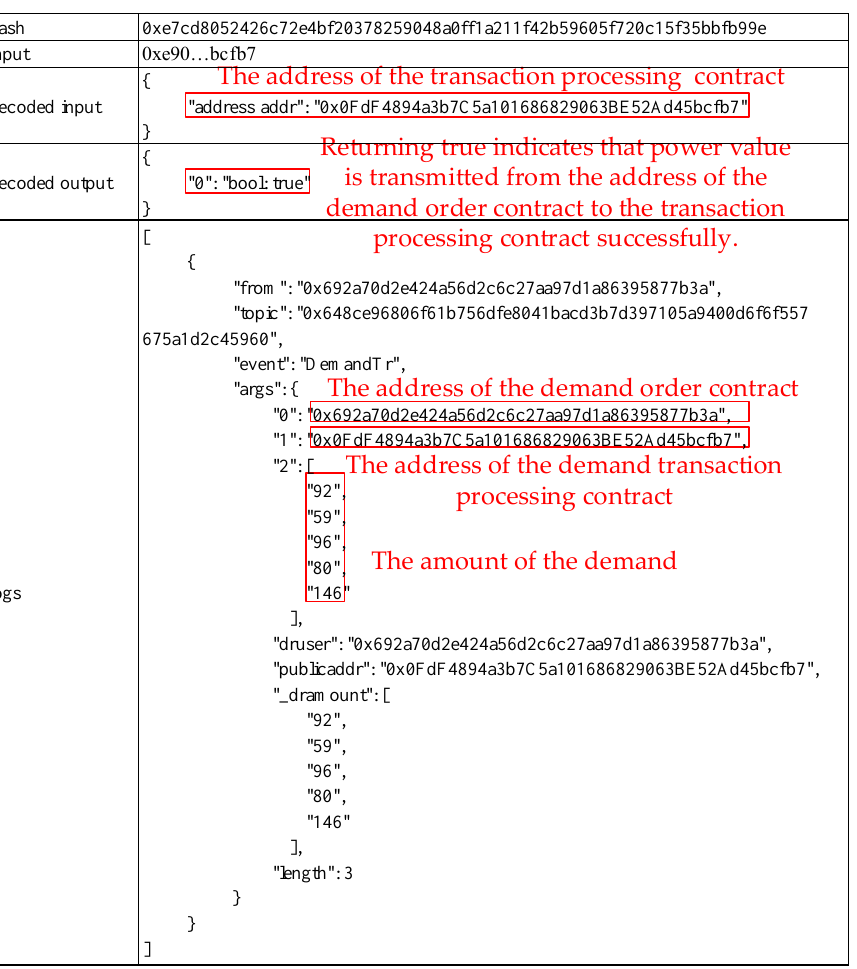
Figure 5. Transferring of buyers’ demand using the initial quoted price .